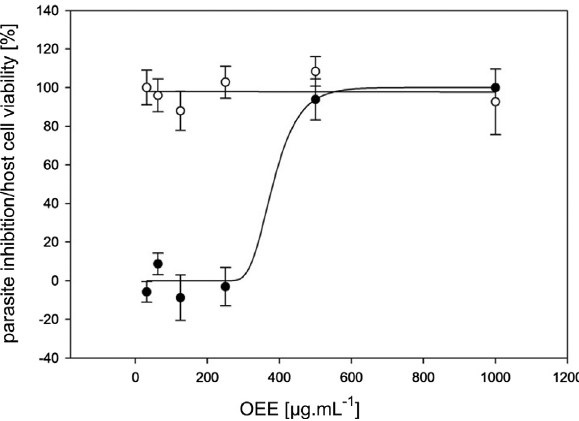
Figure 1. Olive pomace extract inhibits Cryptosporidium par- vum in vitro . Dose-response curve for inhibitory activity of an olive ethanolic extract (OEE; from Olea europaea L. fruit pomace) against Cryptosporidium parvum in vitro (filled dots; Y -axis: parasite inhibition) and viability of HCT-8 host cells (empty dots; Y -axis: cell viability). Error bars represent the standard